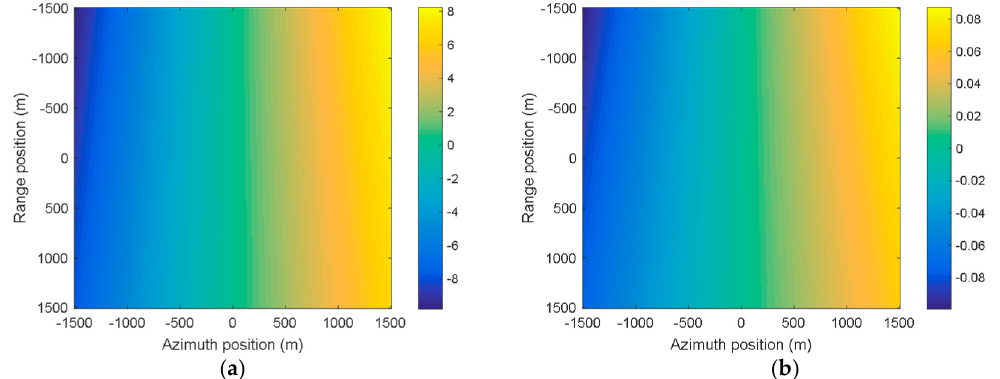
Figure 6. The spatial variance of the Doppler parameters. ( a ) The Doppler rate; ( b ) the derivative of the Doppler rate.